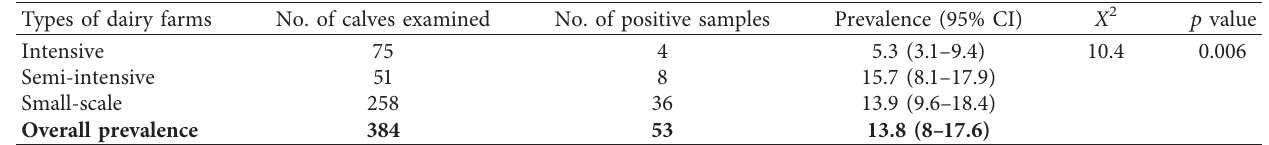
Table 1: Prevalence of cryptosporidiosis in calves based on the types of the farms.